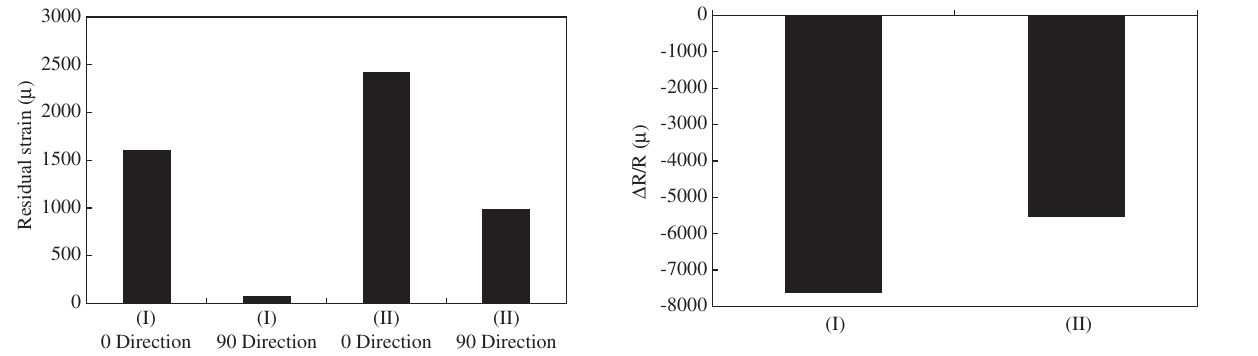
Figure 8 Measured residual strains in the 0 and 90° directions.